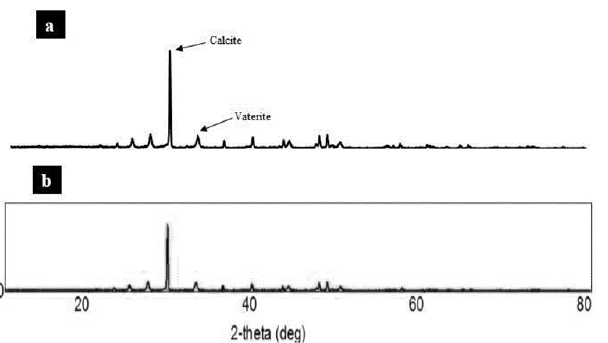
Figure 8. X-ray powder diffraction (XRD) spectra for ( a ) calcium carbonate crystals obtained from ultrasonication samples and ( b ) standard peaks of calcite and vaterite.